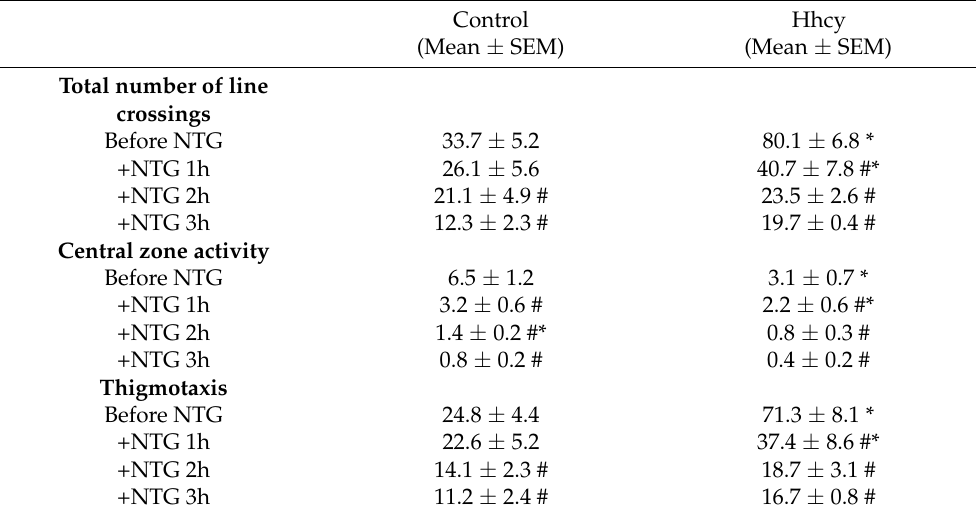
Table 1. Locomotor activity of rats in the open field test before and after NTG administration.